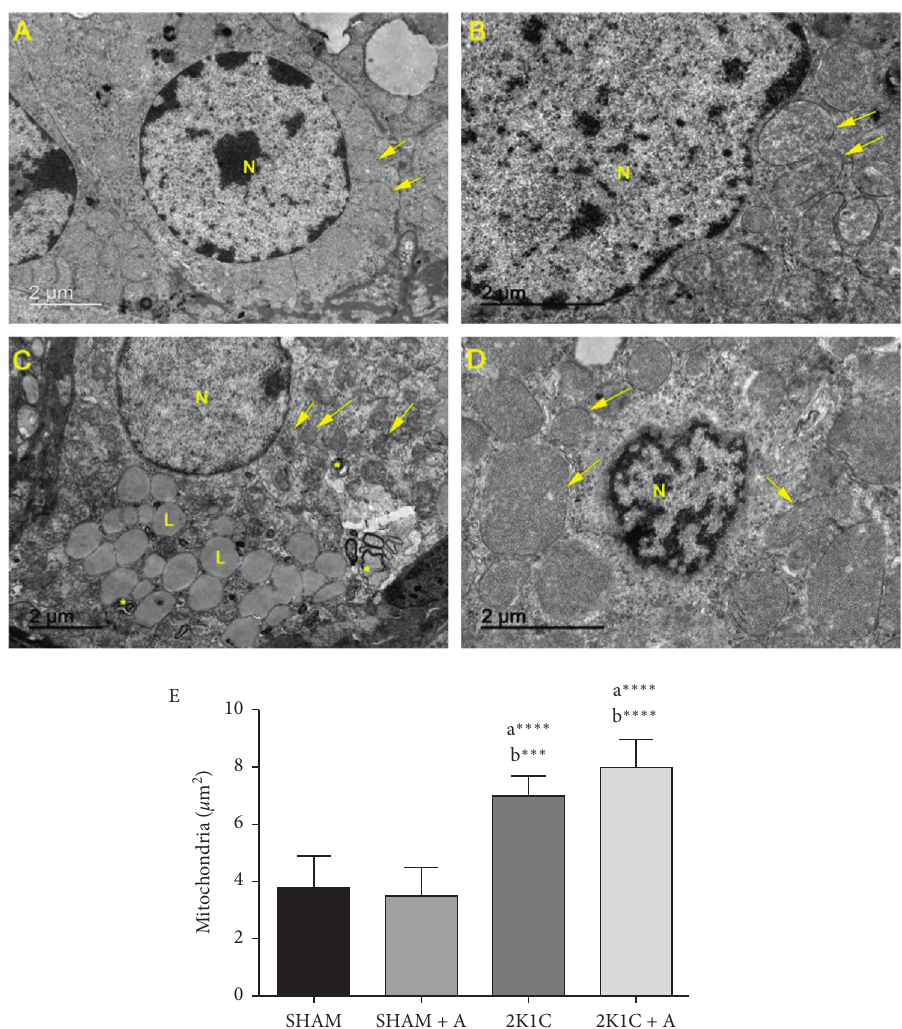
Figure 5: Analysis of zona glomerulosa ultrastructure. Experimental groups: (A) SHAM; (B) SHAM +A; (C) 2K1C; (D) 2K1C +A. The nuclei (N), mitochondria (arrows), lamellar endosomes/lysosomes ( ∗ ), and the lipid bodies (L) are indicated. Quantification of the number of mitochondria in zona glomerulosa of all experimental groups (E). (a) represents ≠ to the SHAM group and (b) represents ≠ to the SHAM +A group. ∗∗∗∗ p < 0 . 0001; ∗∗∗ p < 0 . 001. n � 10 for all experimental